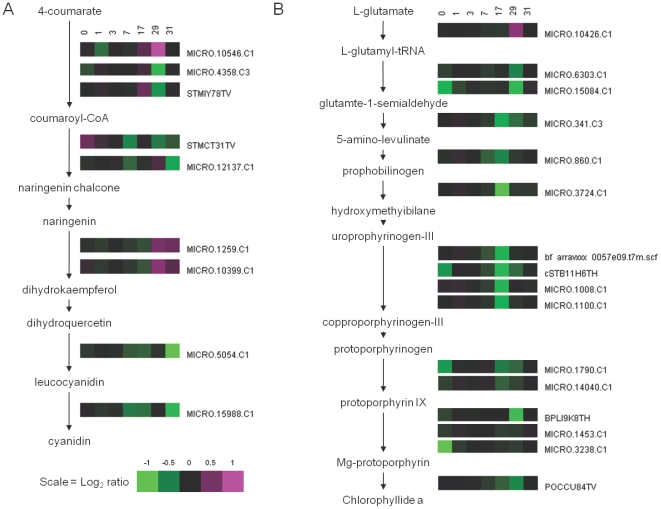
Anthocyanin and chlorophyll pathway analysis.Expression profiles of transcripts with homology to genes that encode proteins involved in (A) anthocyanin biosynthesis and (B) chlorophyll biosynthesis pathways. Pathways were populated with genes using Solanaceae Genomics Network Unigene identifiers and the PotatoCyc pathway tool (http://solcyc.solgenomics.net/expression.html). Numbers above heatmaps are time-points relative to the withdrawal of Pi from the nutrient solution (d), with Pi being re-supplied to the nutrient solution after 28 d.